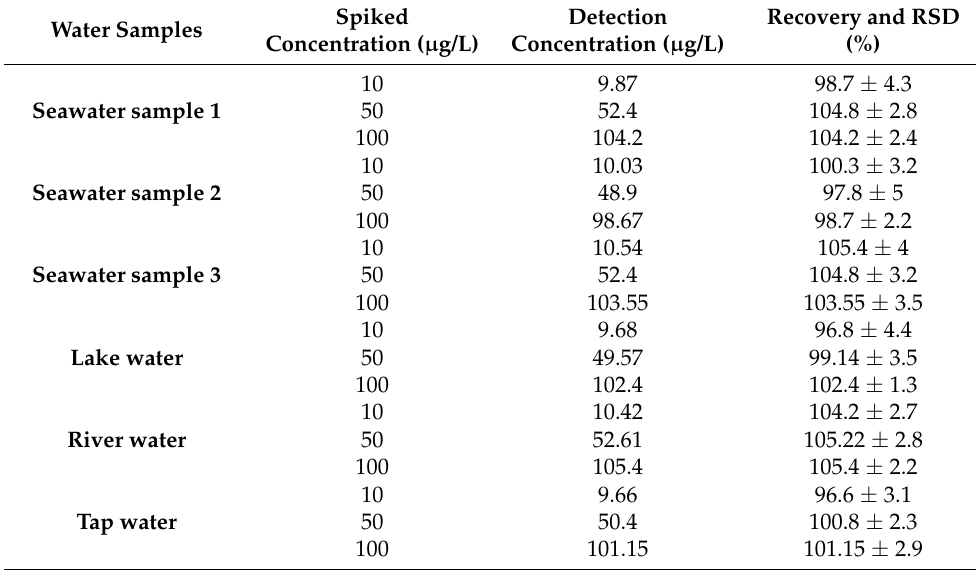
Table 1. Determination of Hg 2+ ions in actual samples using a paper-based chip (n = 5). Water